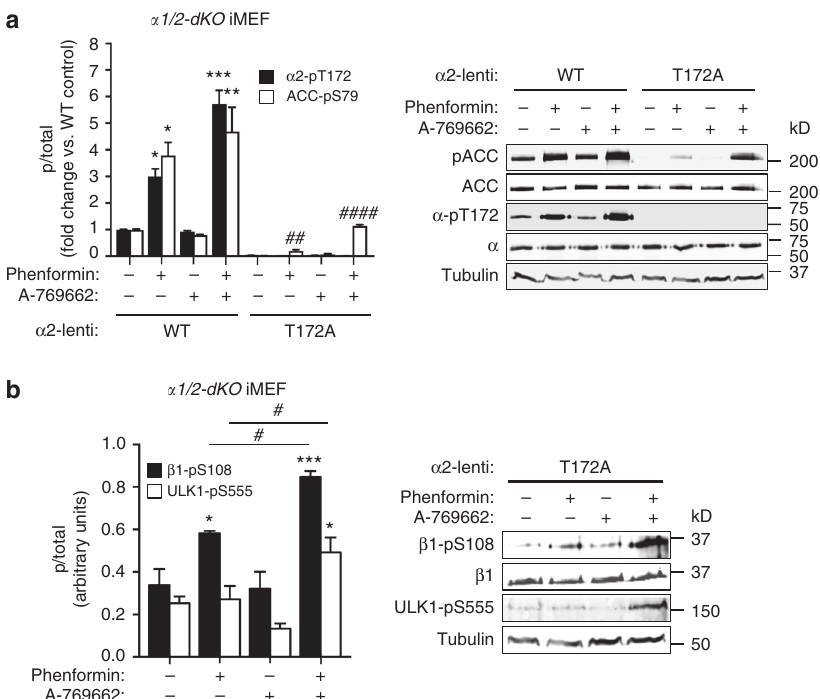
Fig. 8 Cellular AMPK signaling occurs independently of α 1-pThr172. Statistical analyses were performed using one-way ANOVA with post hoc Dunnett ’ s multiple comparison test. a Immunoblots for α 2-pThr172 and pACC from α 1/2-dKO iMEFs-expressing α 2 WT or T172A mutant, stimulated with 2 mM phenformin and/or 100 μ M A-769662 for 1 h. n = 3, representative immunoblots shown. Error bars , mean pThr172 and pACC (fold change vs. untreated WT α 2-expressing cells) ± s.e.m. *** P < 0.001, ** P > 0.01, * P < 0.05 indicate signi fi cant increase compared to basal WT α 2 cells. #### P > 0.0001, ## P < 0.01 indicate signi fi cant increase compared to basal α 2(T172A) cells. b Immunoblots for β 1-pSer108 and ULK1-pSer555 from α 1/2-dKO iMEFs- expressing α 2 T172A mutant, stimulated with 2 mM phenformin and 100 μ M A-769662 for 1 h. n = 3, representative immunoblots shown. Error bars , mean Ser108 and Ser555 phosphorylation (arbitrary units) ± s.e.m. *** P < 0.001, * P < 0.05 indicate signi fi cant increase compared to basal. # P < 0.05